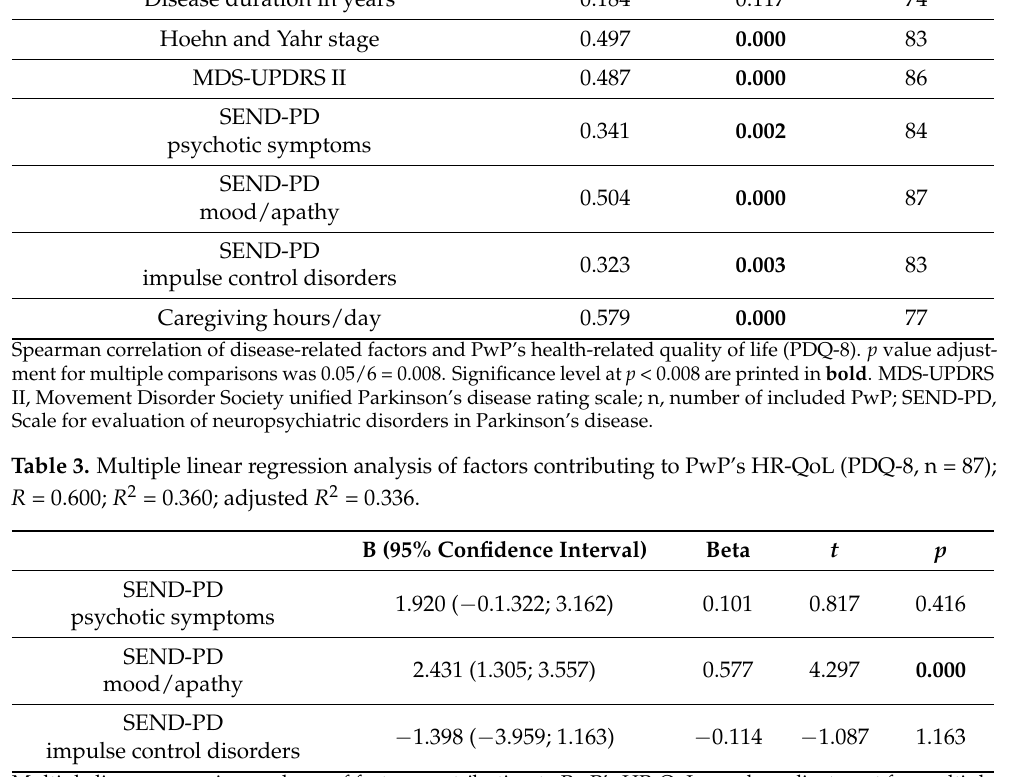
Table 2. Spearman correlation of disease-related factors and PwP’s health-related quality of life (PDQ-8, n = 87). Disease duration in years